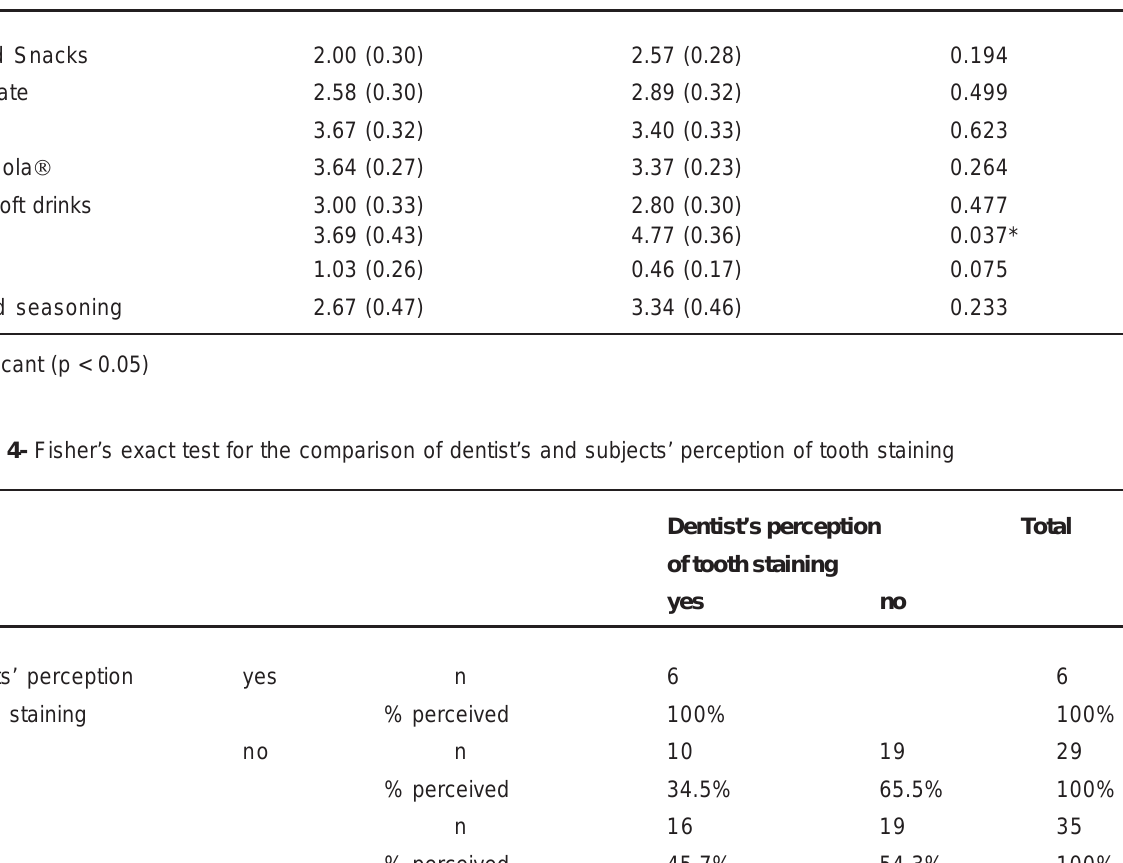
TABLE 3- Mann Whitney U test for the consumption frequency of possible staining agents reported by the adolescents